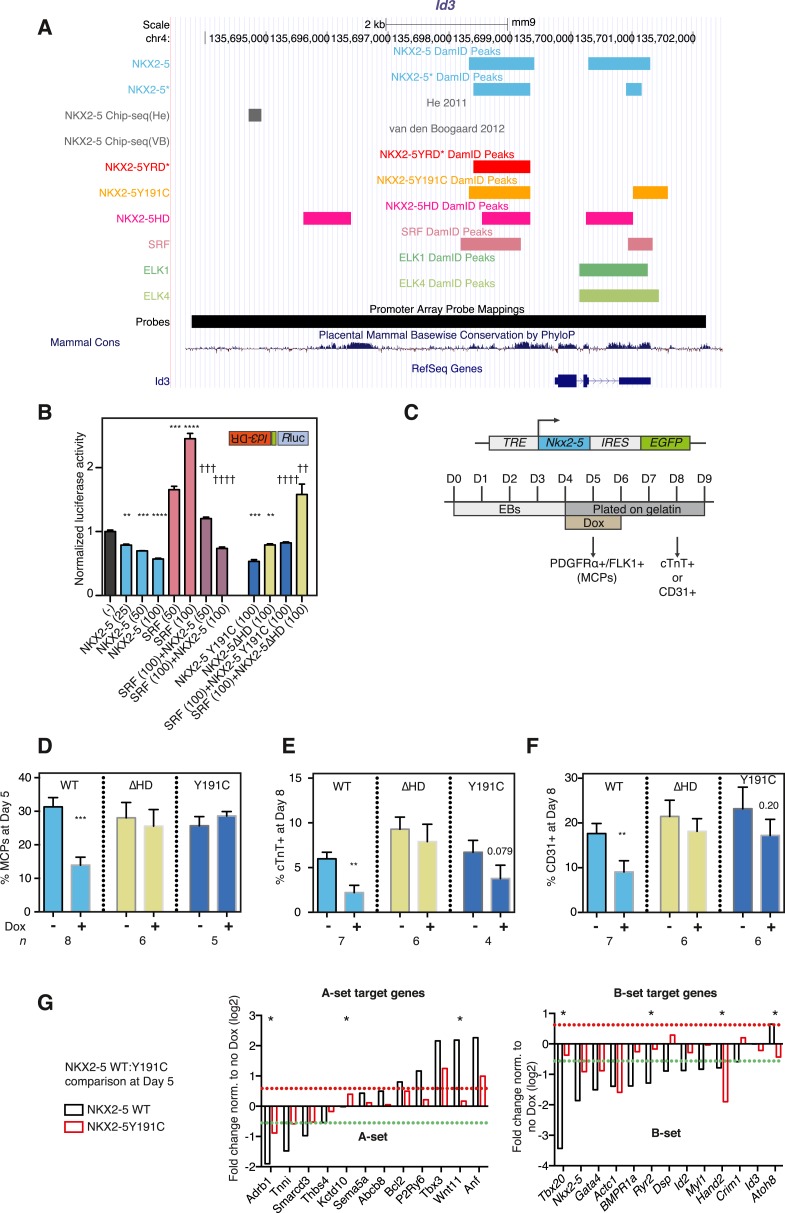
NKX2-5 mutant proteins retained partial functionality.(A) UCSC Genome Browser screen shot showing DamID transcription factor (TF) association in HL-1 cells with Inhibitor of DNA binding 3 (Id3). (B) Normalised Rluc activity in HEK 293 cells transfected with NKX2-5 and serum response factor (SRF). Id3 DR was in the antisense orientation. p-values were calculated relative to controls (** p < 0.01; *** p < 0.001; **** p < 0.0001; ns = not significant) or SRF alone (†† p < 0.01; ††† p < 0.001; †††† p < 0.0001). The quantity of vector is given in ng. (C) Schematic representation of ‘Materials and methods’ for the generation of embryonic stem (ES) cell lines for inducible expression of NKX2-5 WT and mutants. Cardiac differentiation was initiated in embryoid bodies (EBs), followed by induction of cardiogenesis differentiation (from day 4) on plates. (D) FACS quantification of PDGFRa/FLK1+ multipotent cardiovascular progenitors (MCPs) in NKX2-5 dox-inducible ES cell lines (at day 5). The mean of 6–7 independent experiments is shown. (E, F) FACS quantification of cTNT + cardiomyocytes (D) and CD31+ endothelial cells (E) at day 8. (G) RT-PCR quantification of A- and B-set target genes in NKX2-5 WT or Y191C dox-inducible ES cell lines at day 5 in three independent experiments (24 hr post-induction). Results were normalised to expression in uninduced cells. p-values were calculated using a t-test (* p < 0.05).